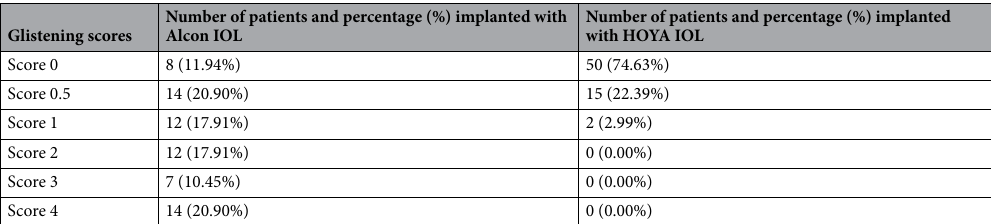
Number of patients and percentage (%) implanted with HOYA IOL